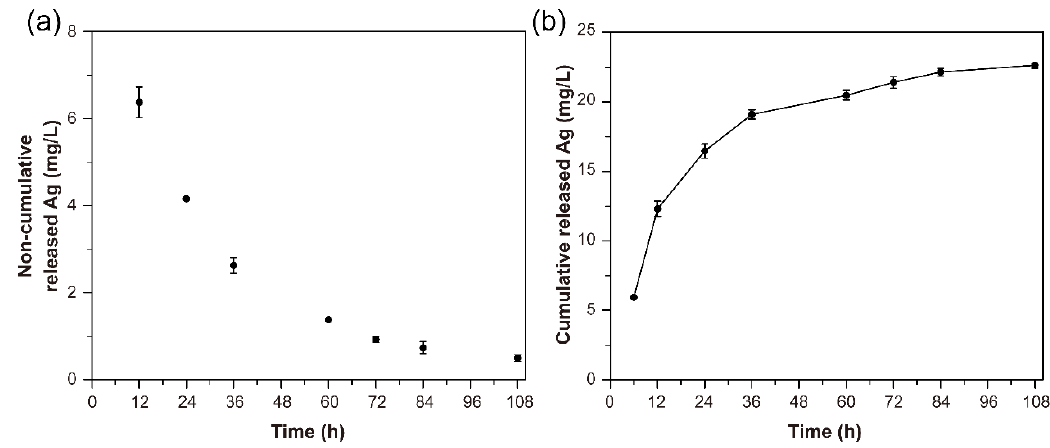
Figure 9. Degradation of AgNPs ‐ PEM ‐ SS/Agar film at pH 4.0, 7.4, 10.0.